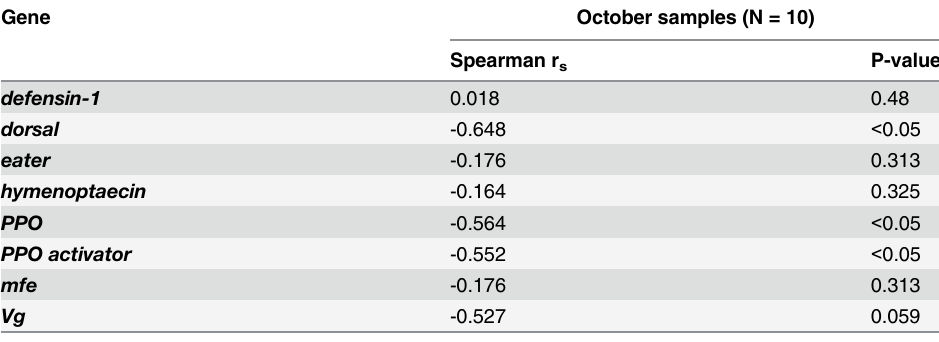
P values < 0.05 were considered signi fi